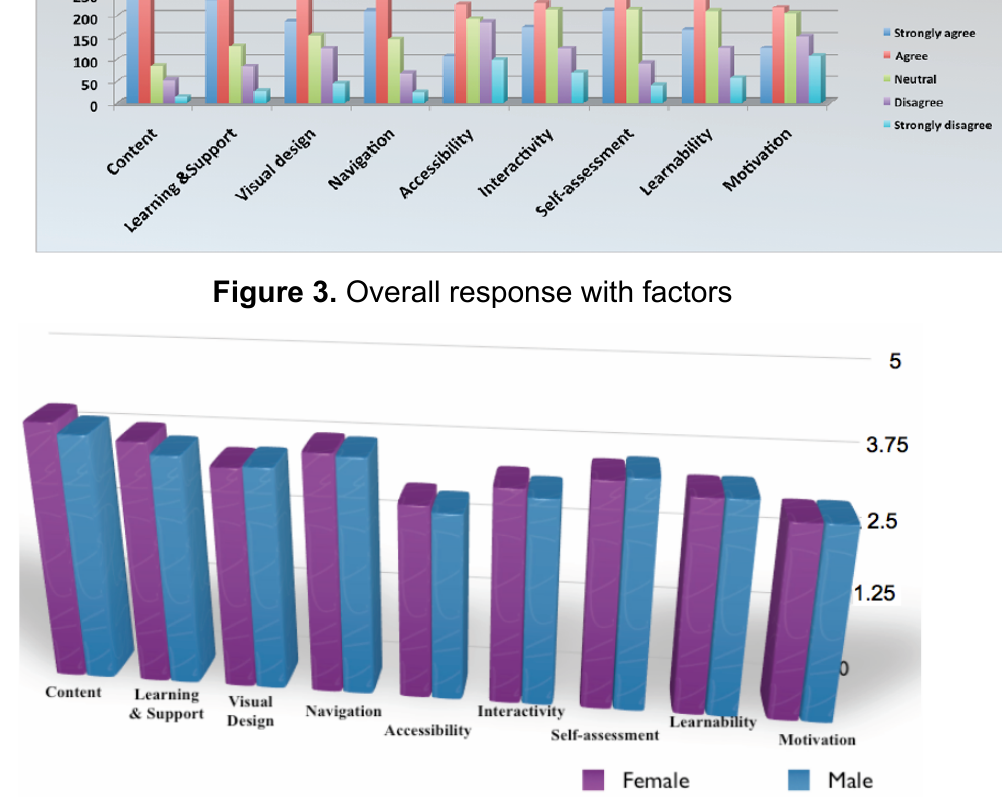
Figure 4. Average ratings for Jusur by